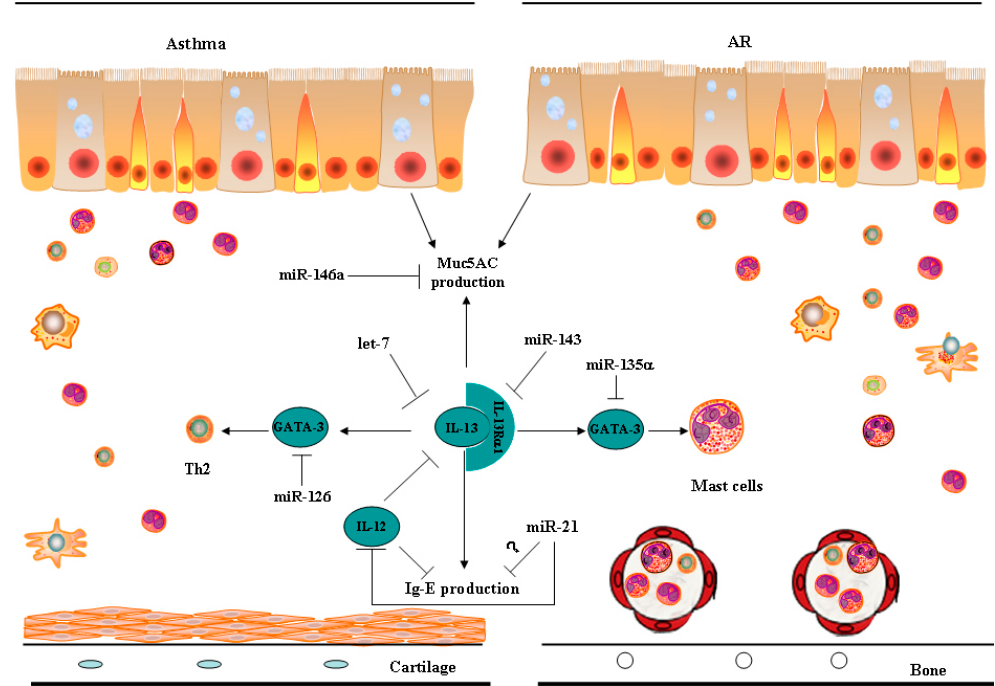
Figure 1. A summary of miRNAs potentially involved in the common pathways in allergic rhinitis and asthma. Effects of induction or stimulation (black arrows), repression or inhibition (T arrows) or indirect repression or inhibition (question mark) are shown.